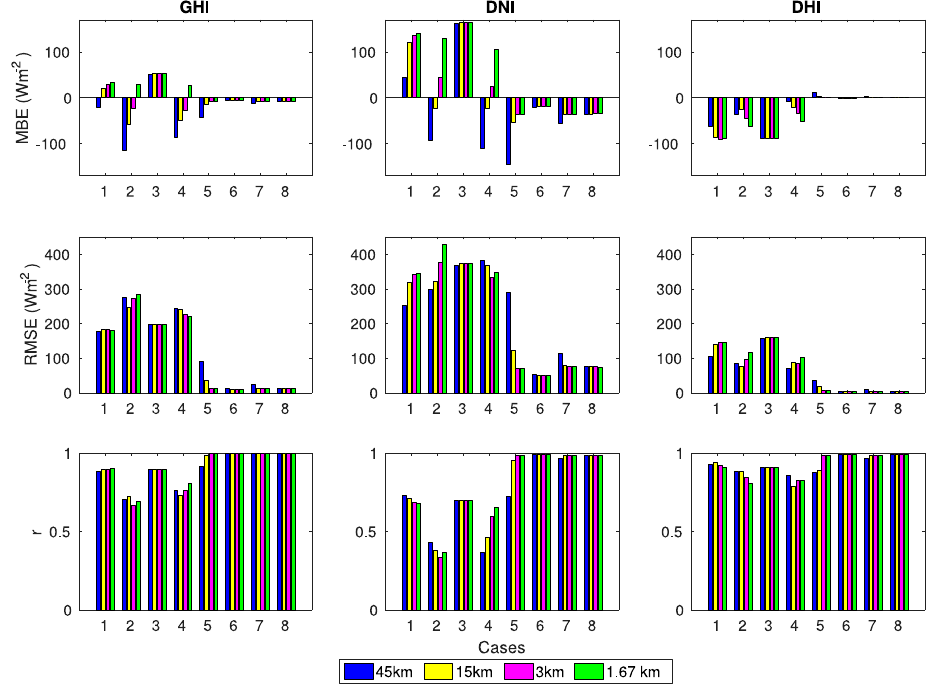
Figure 4. Evaluation statistics mean bias error (MBE, top), root mean square error (RMSE, middle), and r (bottom) for solar irradiance variables global horizontal irradiance (GHI, left), direct normal irradiance (DNI, centre), and direct horizontal irradiance (DNI, right) for intermittent (1–4) and clear cases (5–8) simulated with WRF-Solar.